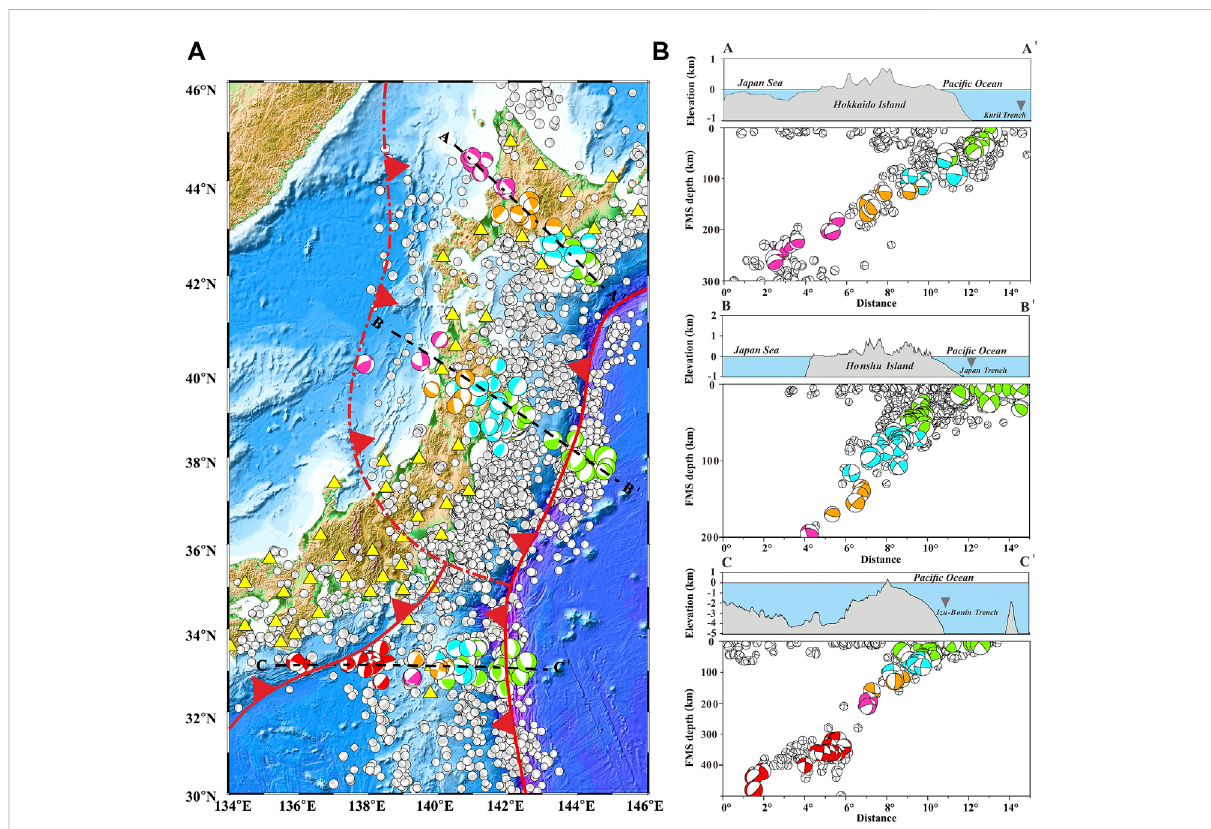
FIGURE 3 Focalmechanism solutions(FMS)instudyareawiththelowerhemisphereprojectedontotheplane.Theredsolid(dash)lineandrepresentsthe boundary (presumed boundary) of the plates, with red triangles on it indicating the direction of movement of the plates. Three tectonic segments (Pro fi leA-A ’ andB-B ’ and C-C ’ )are plotted with blackdotted lines. Theboundariesoftheplatesareindicated bytheredlines andstations areshown in yellow triangles. Beach balls with color- fi lled compressional quadrants were calculated in this study. The solutions with gray- fi lled compressional quadrants are from Japan Meteorological Agency (JMA) with time period 2012 – 2021. Compressional quadrants of all shallow ( ≤ 60 km) FMS are green in color. FMS with FMS depth ranges 60 – 120 km, 120 – 180 km, 180 – 300 km are cyan, orange, and pink in color, respectively. Compressional quadrants of all deep (300 – 500 km) of FMS are red in color. The Mechanisms are magnitude-wise size scaled (the colored beach balls have twice the radius of gray ones). (B) Depth-wise distribution of faulting mechanism solutions (the hemisphere behind the vertical plane is projected onto the plane) across the pro fi les are shown in (B) . Corresponding topography, along the same pro fi le lines are plotted above with the sea level below fi lled with light blue. Labeled inverted grey triangles represent the location of the trench. Topographic data is from Tozer et al. (2019). The color of the FMS compressional quadrants is the same as that in (A)